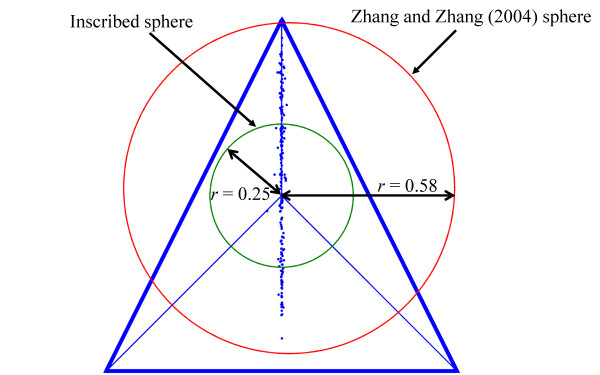
Points of 235 bacterial genomes mapped to a regular tetrahedron with a height of 1 and edge lengths of /2. Here, the face of the tetrahedron towards the observer is flat against the plane of projection. The points are mapped according to Z-curve coordinates with an origin in the center of the tetrahedron. The two spheres in the figures are an inscribed sphere of a regular tetrahedron with a radius of 0.25 and the sphere calculated by Zhang and Zhang [7]. Forty five percents of the points P are found outside the inscribed sphere thus violating the "constraint."